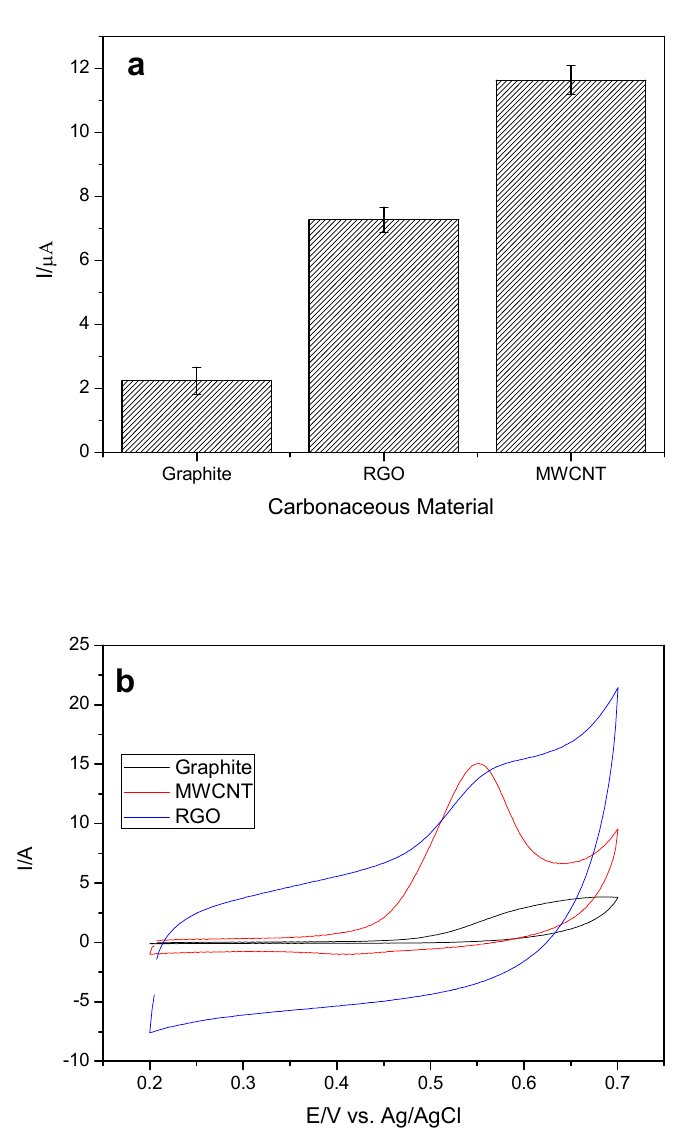
Figure 4. ( a ) Evaluation of carbonaceous materials in the presence of 175 μmol L −1 of ethinyl estradiol. ( b ) Cyclic voltammograms for different metal phases in the presence of 175 μmol L −1 of ethinyl estradiol. Buffer solution Phosphate 0.1 mol L −1 , pH 7.0. Cyclic voltammetry, scan rate 0.01 V s −1 .